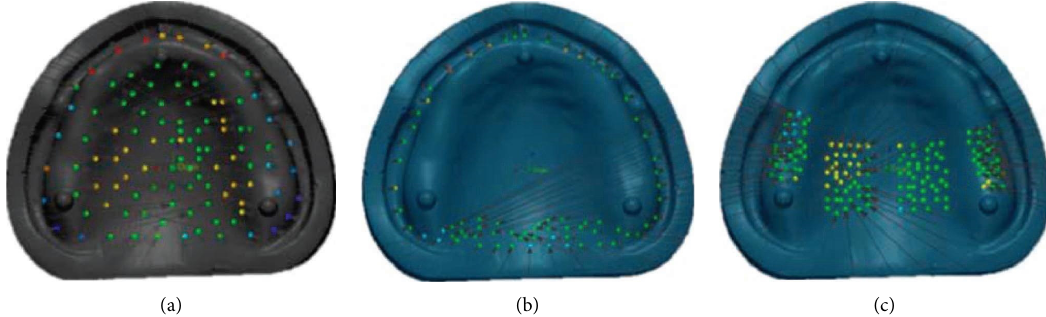
Figure 3: Te adaptation evaluation performed in three areas. (a) Overall intaglio surface with 105 measuring points. (b) Peripheral/ posterior palatal seal area with 72 measuring points. (c) Primary bearing area with 140 measuring points. Table 1: Descriptive statistics showing RMSE values (the mean ± standard deviation in mm) of three diferent area of measurements. Groups 0 ° 45 ° 90 ° Overall surface area 0.1209 ± 0.0033 a 0.1265 ± 0.0036 a 0.1219 ± 0.0037 a Peripheral and posterior palatal seal areas 0.2245 ± 0.0086 A Primary bearing area 0.0618 ± 0.0018 α 0.0408 ± 0.0018 β 0.0498 ± 0.0031 β Same letters in each row indicate statistically no signifcant diference ( α � 0.05).